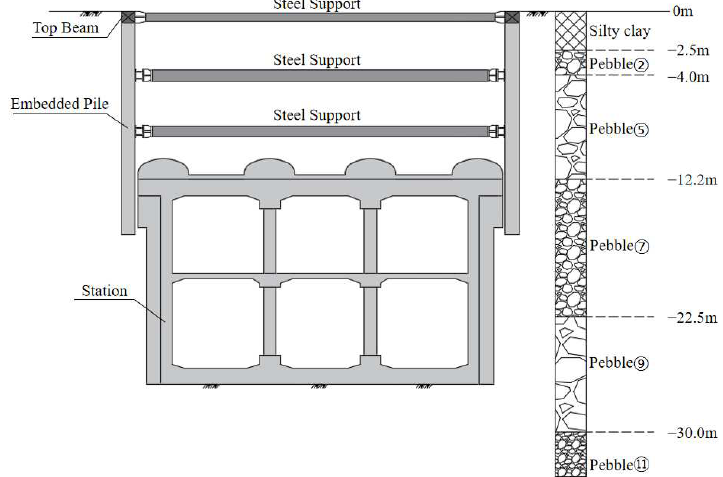
Figure 2. Soil layer distribution of transfer hall by open excavation in Pingguo Yuan